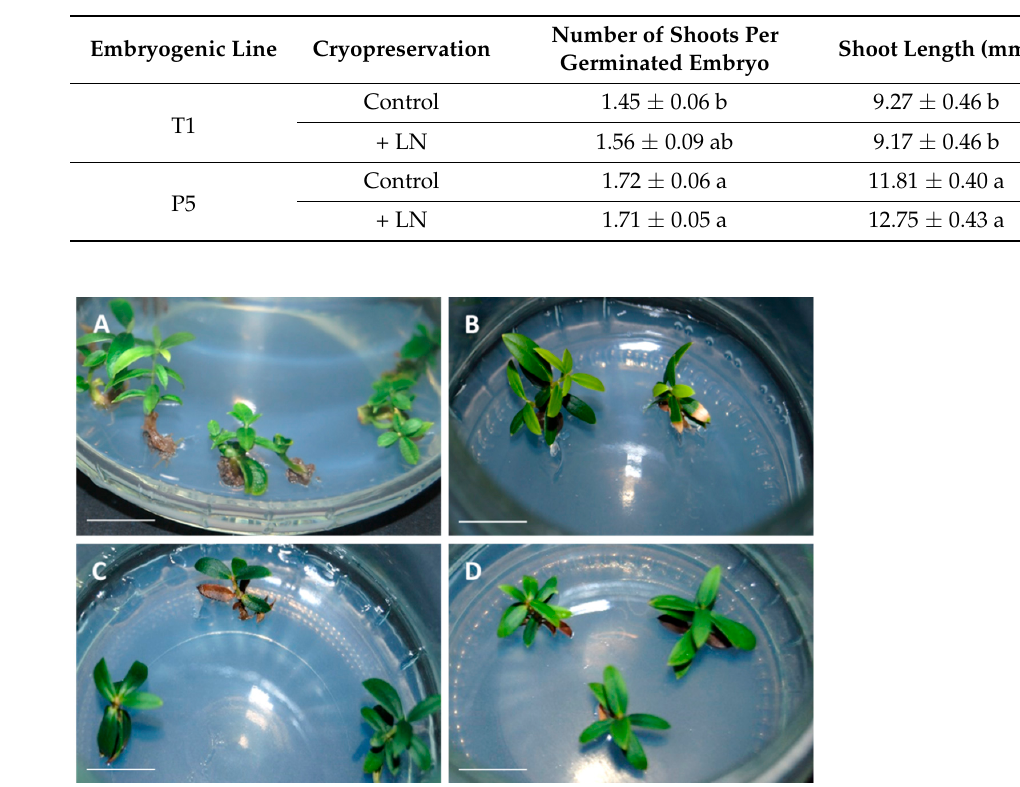
Figure 3. In vitro multiplication of olive plants derived from ( A , C ) control and ( B , D ) cryopreserved embryogenic cultures of the lines T1 ( A , B ) and P5 ( C , D ). Bar = 1 cm.